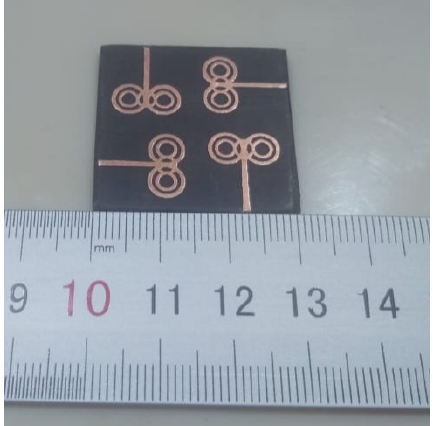
Figure 3. Fabricated prototype of MIMO array.